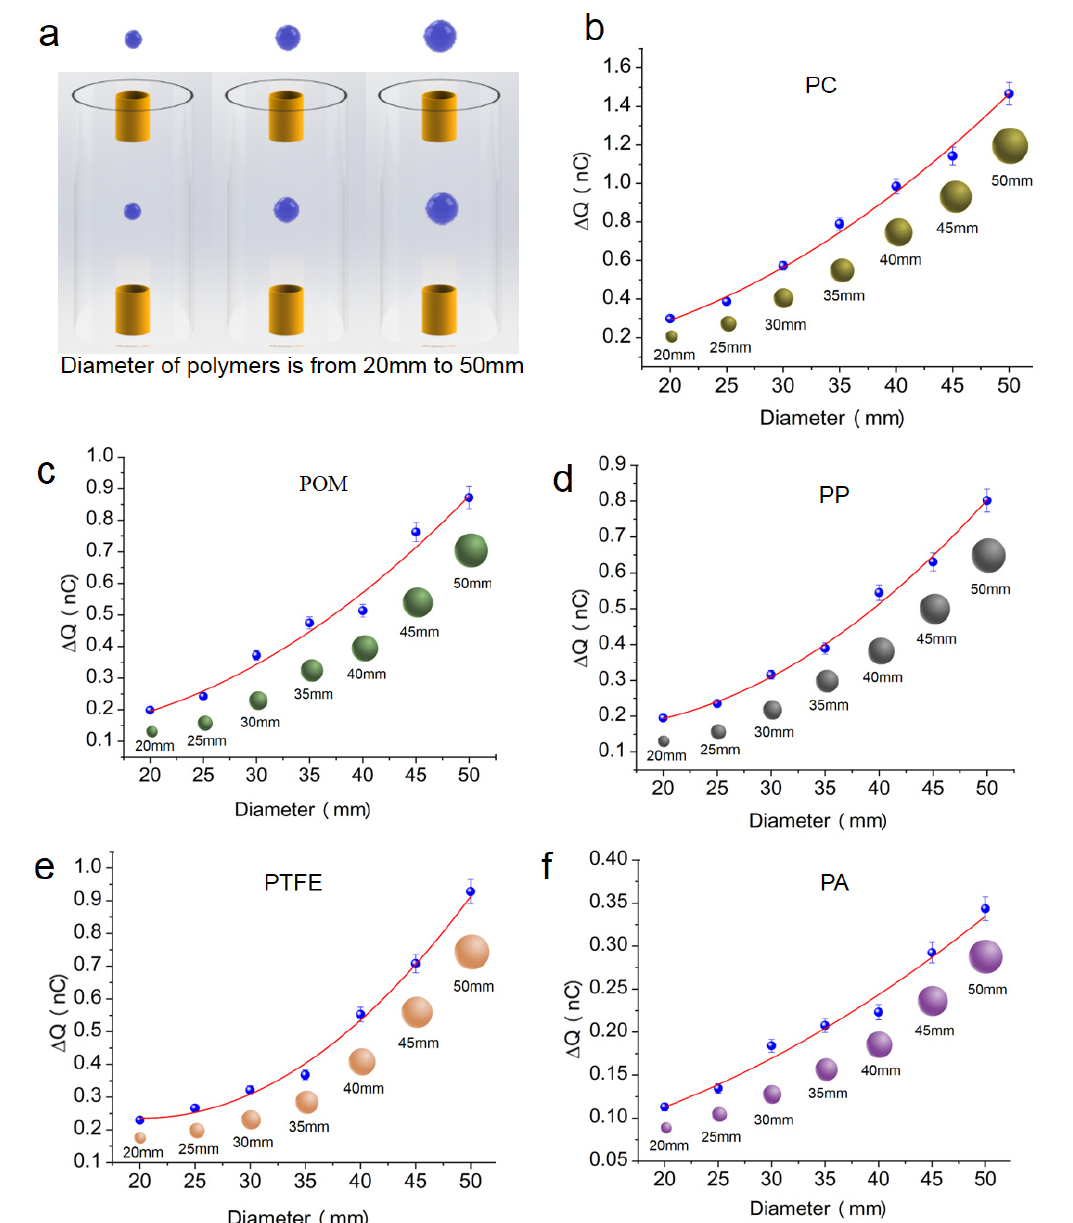
Figure 2. Effects of surface area on gas–solid contact electrification. ( a ) The testing principle of gas–solid contact electrification under different contact areas. ( b – f ) The relationship between the transferred charge and the contact area in the process of gas–PC, gas–POM, gas–PP, gas–PTFE, and gas–PA contact